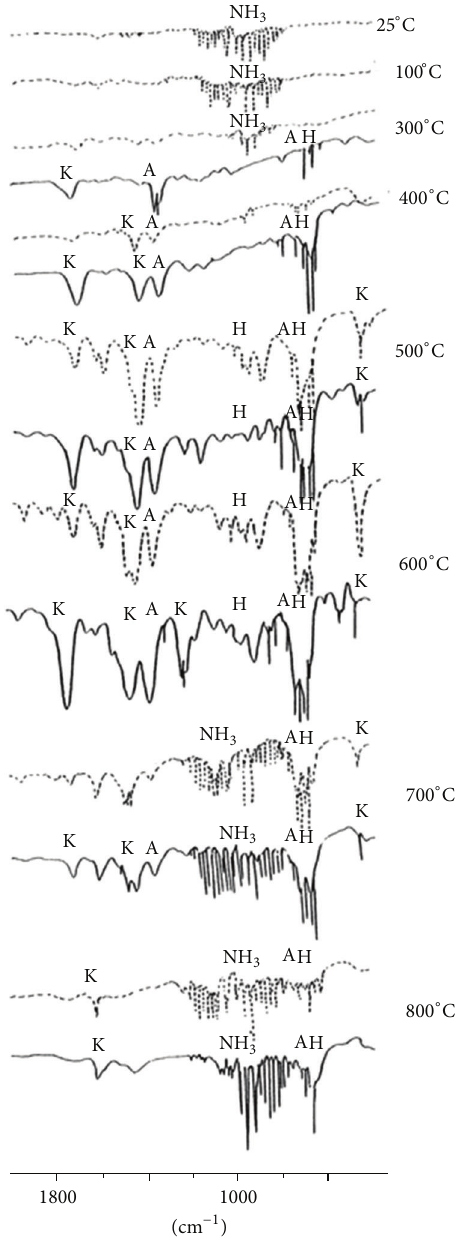
Figure 4: FT-IR spectra in 2000–400 cm −1 region of vapors obtained at different temperatures from Sulcis (—) and South Africa (---) coals sampled in the cooling trap (b). K = ketones, A = aromatic hydrocarbons, and H = aliphatic hydrocarbons (saturated and